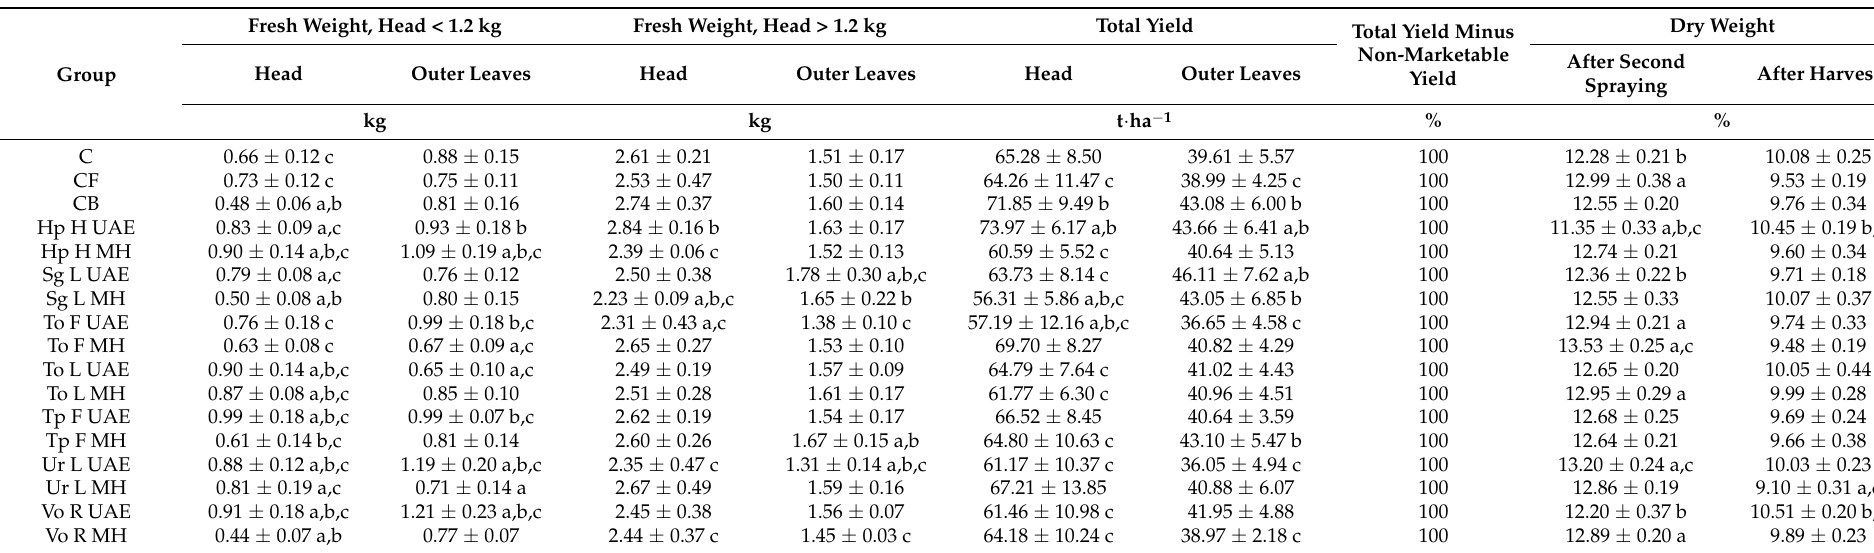
Table 1. Effect of the foliar application of the botanical extracts on the average fresh weight of cabbage head and outer leaves after harvest, the total yield of cabbage ( n = 3 *, mean ± SD), and dry weight of leaves after second spraying and cabbage head after harvest ( n = 3, mean ± SD).